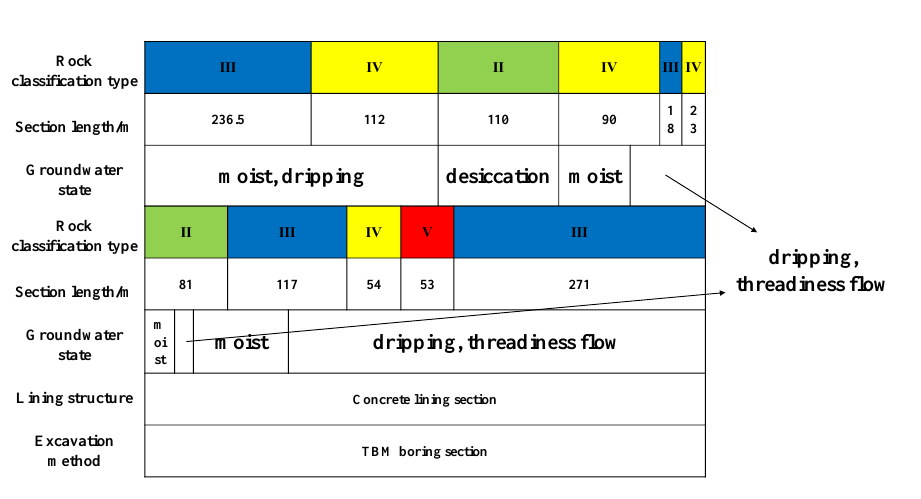
Figure 3. Geological section map of Jilin water transport tunnel (part).